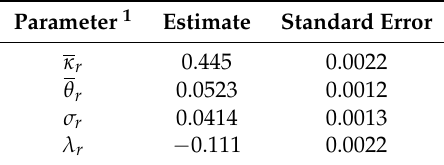
1 κ r and θ r are parameters under P measure.